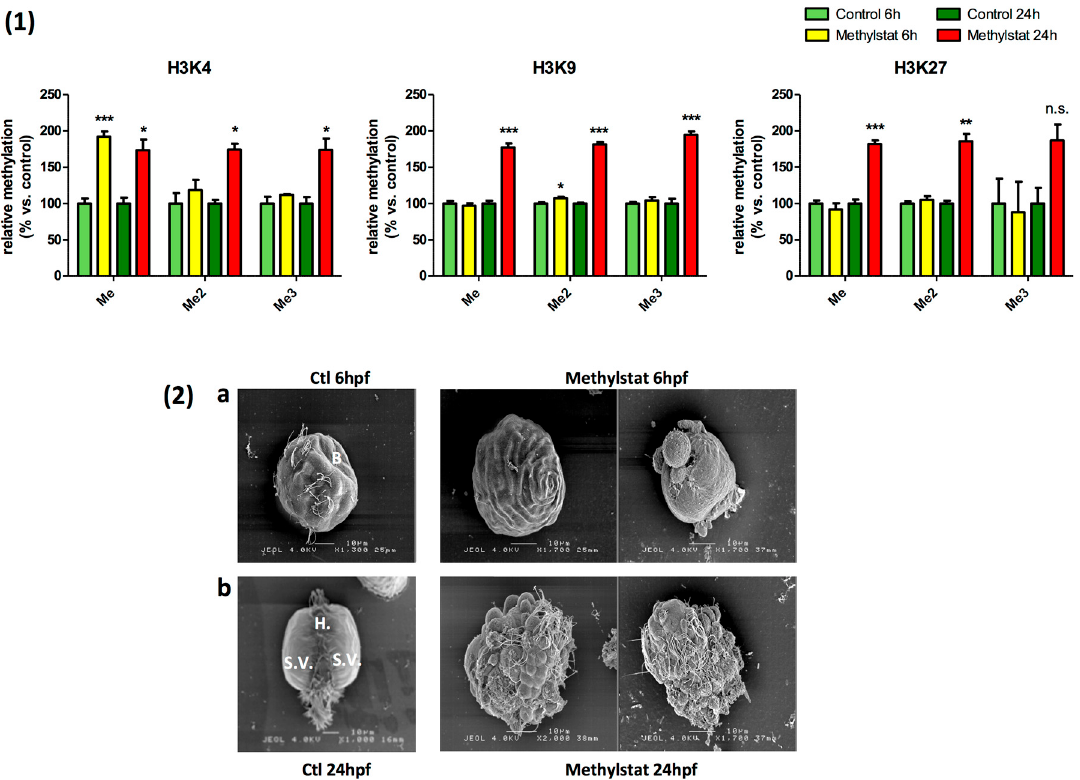
Figure 2. ( 1 ) Hypermethylation of histone lysine residues in presence of 10 µ M Methylstat. Global H3K4 methylation increase in presence of methylstat, but only H3K4me1 and H3K4me3 are significant. Global H3K9 methylation increase in presence of methylstat, but only H3K9me2 is significant. H3K27me and H3K27me2 increase in presence of methylstat. Asterisk in the legend indicates significant variation of the indicated mark (One-way ANOVA; p < 0.05 was considered significant (<0.05 (*), <0.001(**), <0.0001(***)). ( 2 ) Abnormal development. Different phenotypes observed in control condition and under methylstat treatment at 6 h after fertilization ( a ) and 24 h after fertilization ( b ).